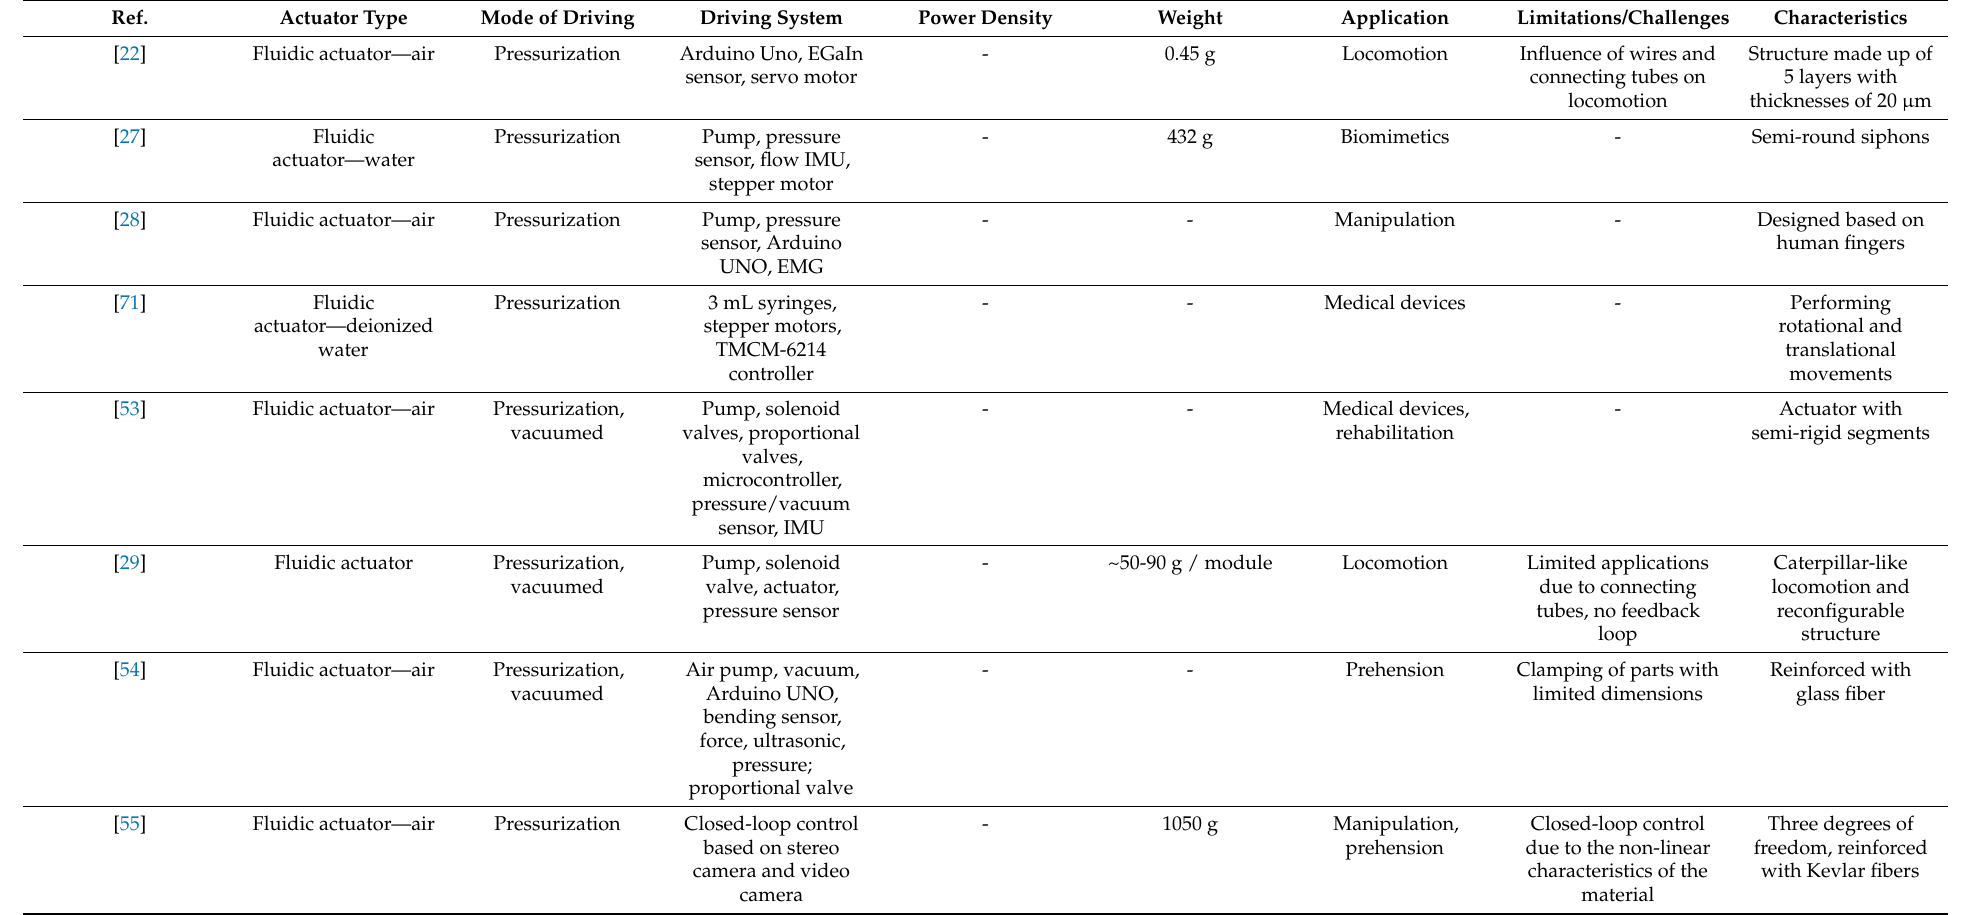
Table A3. Analysis of bibliographic references according to the